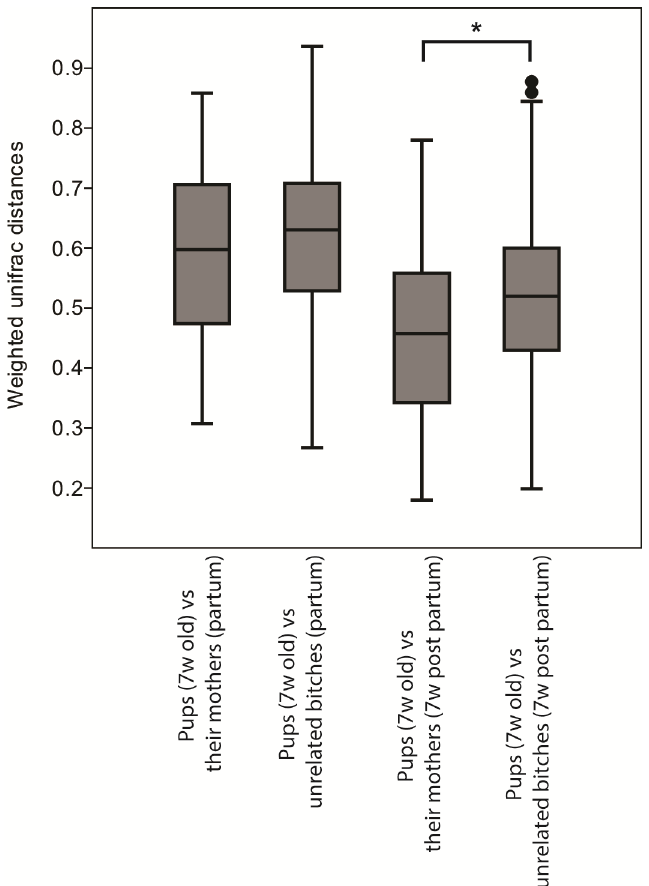
Fig 6. Boxplot showing the distribution of weighted unifrac distances comparing the composition of the microbiota in 7 weeks old puppies with their mothers at partum and 7 weeks postpartum, and with unrelated bitches at partum and 7 weeks postpartum. A distance of 0 represents an identical composition of the microbiota whereas 1 represents a total dissimilarity.